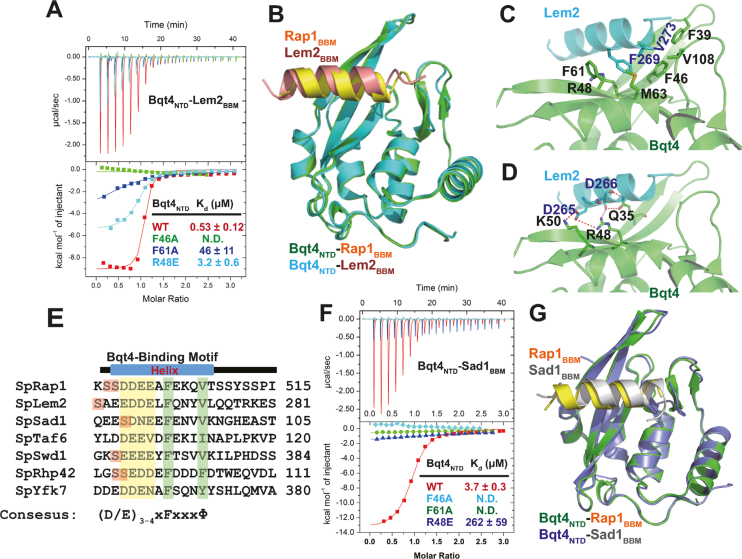
Bqt4NTD recognizes a conserved motif. (A) ITC measurements of the interaction between Bqt4NTD and Lem2BBM. The upper panel is the heat change upon titration of Rap1 into Bqt4 and the lower panel is binding isotherm fit to one binding site model. (B) Superimposition of Bqt4NTD–Lem2BBM and Bqt4NTD–Rap1BBM structures. Bqt4NTD in Bqt4NTD–Lem2BBM complex is colored in cyan and Lem2BBM is colored in red. Bqt4NTD in Bqt4NTD–Rap1BBM complex is colored in green and Rap1BBM is colored in yellow. (C) Details of hydrophobic interactions between Bqt4NTD and Lem2BBM. (D) Details of electrostatic and hydrogen-bonding interactions between Bqt4NTD and Rap1BBM. (E) A conserved Bqt4-binding motif found in some fission yeast proteins. Φ stands for hydrophobic residues. (F) ITC measurements of the interaction between Bqt4NTD and Sad1BBM. Sad1BBM bound to Bqt4NTDWT but not with Bqt4NTDF46A, Bqt4NTDF46A, and Bqt4NTDR48E. (G) Superimposition of Bqt4NTD–Sad1BBM and Bqt4NTD–Rap1BBM structures showed almost identical configurations of these two complexes.